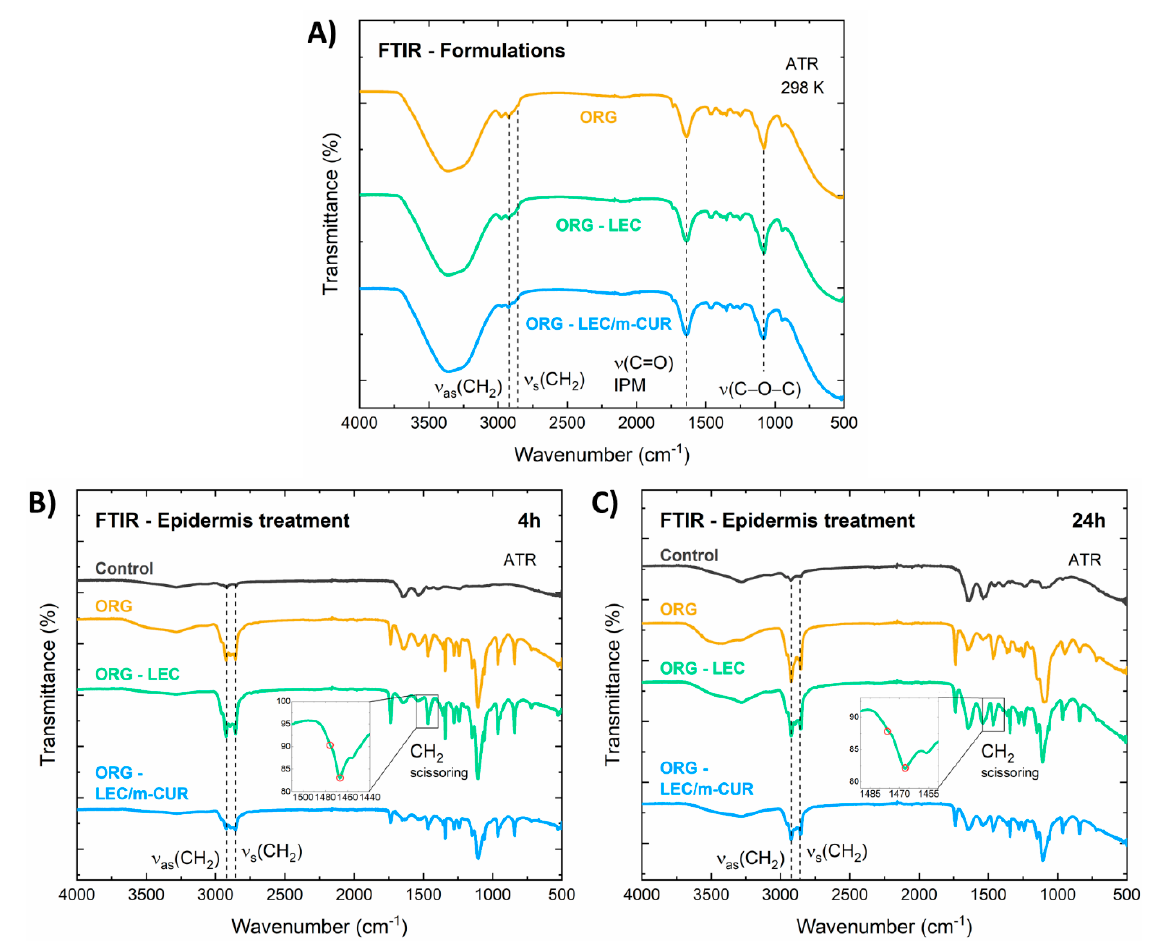
Figure 7. ATR-FTIR characterization of the ( A ) ORG, ORG-LEC, and ORG-LEC/m-CUR formulations, as well as the stratum corneum (SC) samples treated with these formulations for ( B ) 4 h and ( C ) 24 h. FTIR of a SC control sample (without ORG treatment) was also displayed.